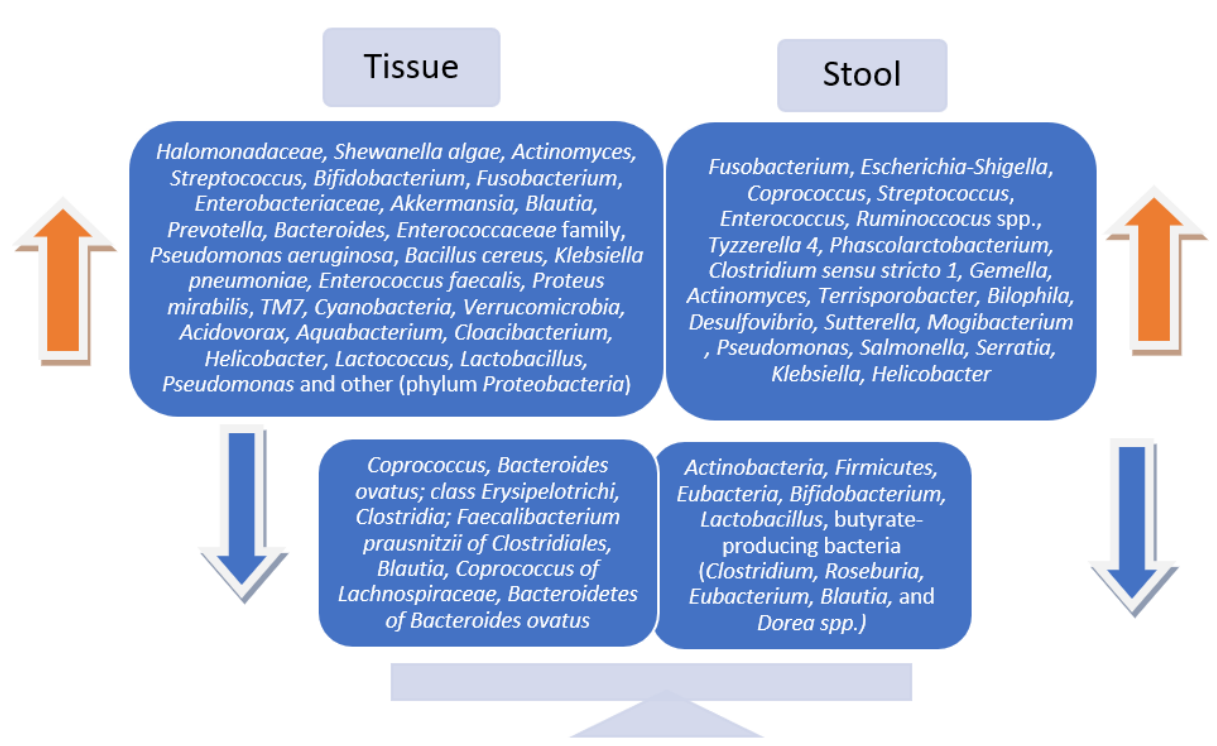
Figure 2. Bacterial abundances in tissue vs. stool samples in patients with precancerous colorectal lesions.